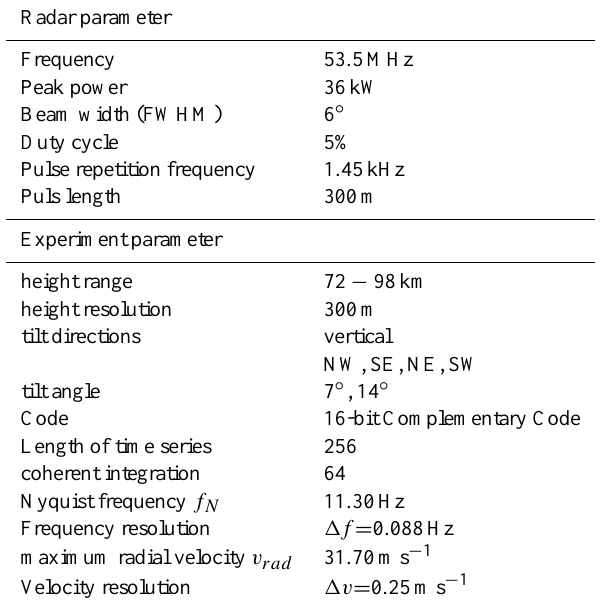
Table 2. Launch times of the sounding rockets during the MI- DAS/MaCWAVE campaign in 2002. The apogee was reached 3min after the launch of the